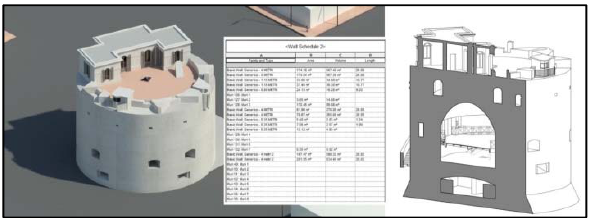
Figure 4. The informative model HBIM developed in Revit